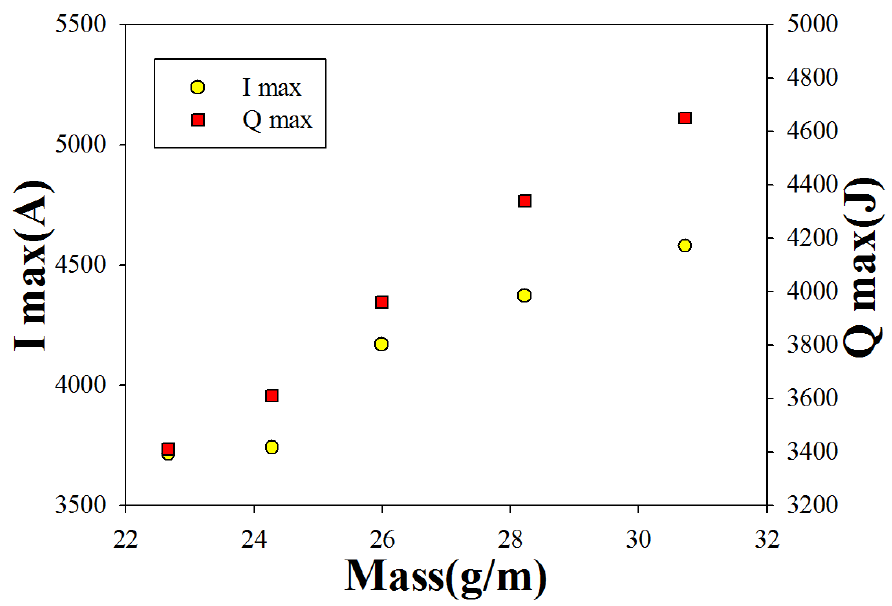
Figure 12. Impact tolerance performance of samples 4 and 9–12.